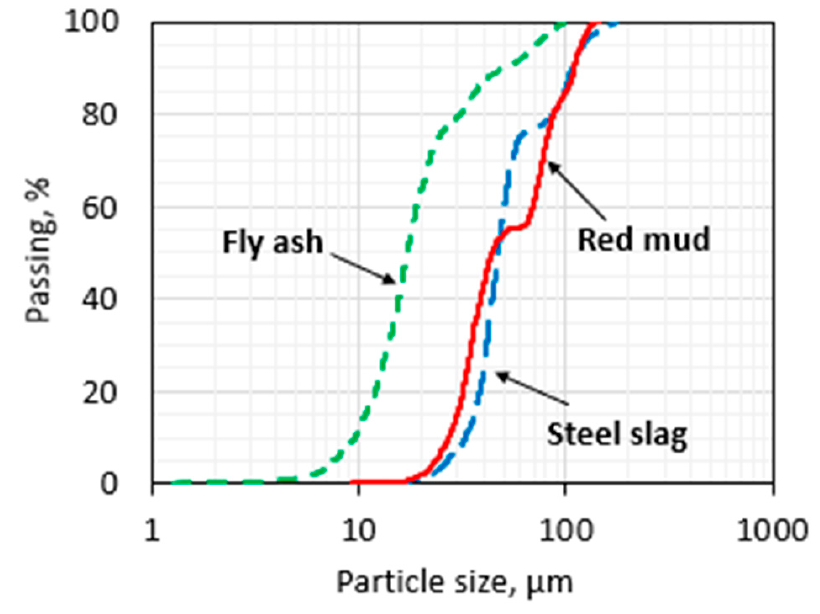
Figure 1. Particle size distribution.